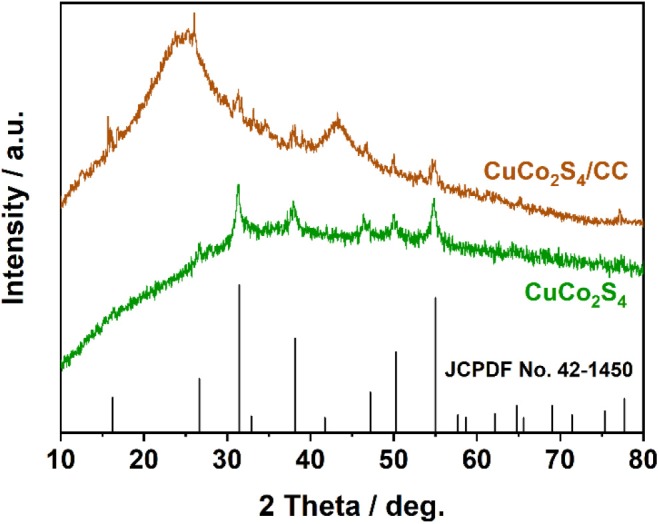
XRD patterns of CuCo2S4/CC and CuCo2S4.